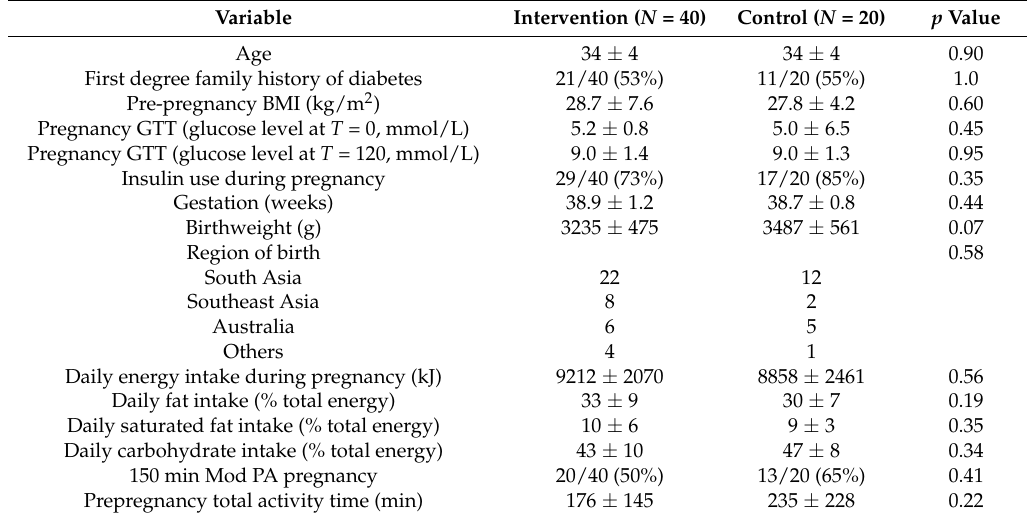
Table 1. Subject baseline characteristics. Data are presented as mean ± SD or proportion